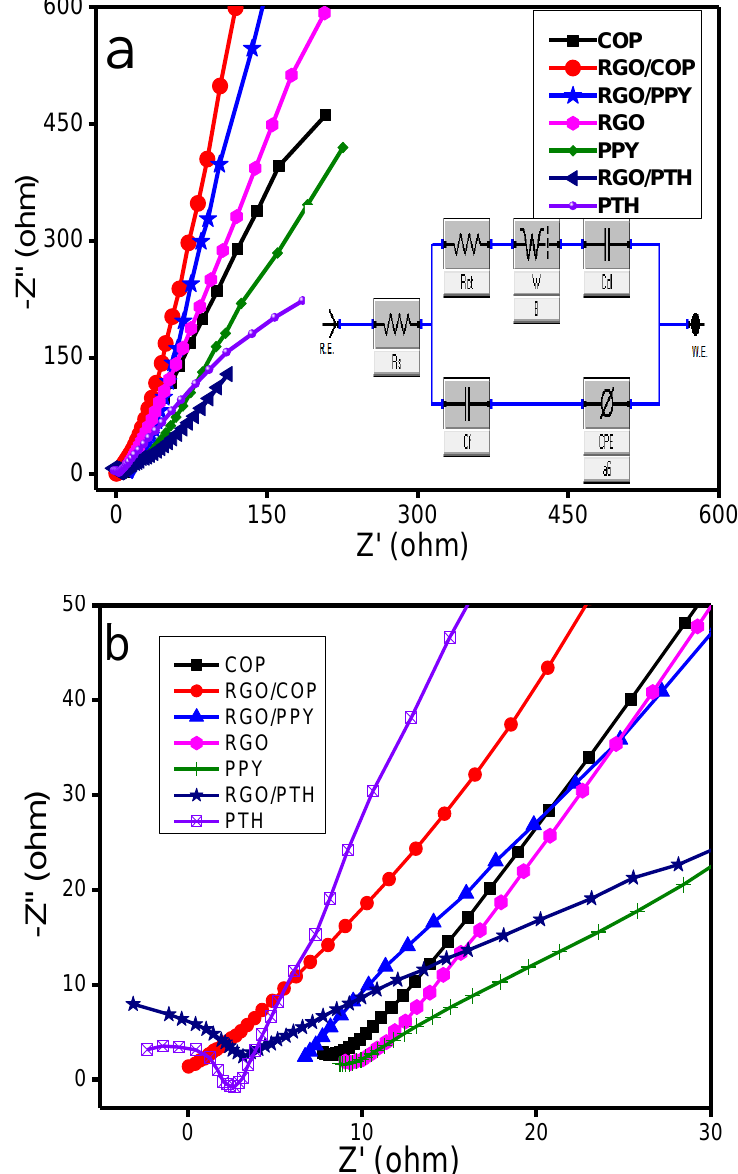
Figure 12. ( a ) Nyquist plots of the synthesized materials recorded in the frequency range of 0.1–10 5 Hz with 5 mV amplitude in 0.5 M H 2 SO 4 (equivalent circuit is shown in the inset) ( b ) magnification of high frequency region of plots shown in ( a ). Table 2. The equivalent circuit fitting values of various elements of the synthesized samples in Figure 12.